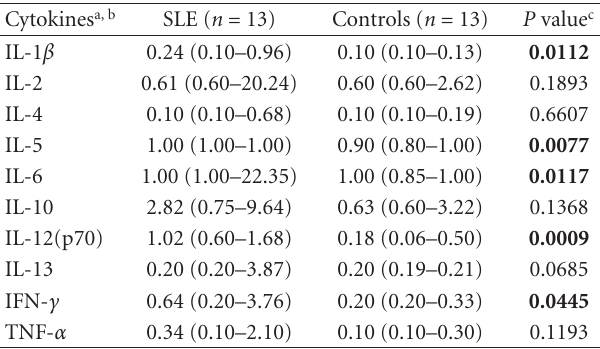
Table 4: Cytokines plasma